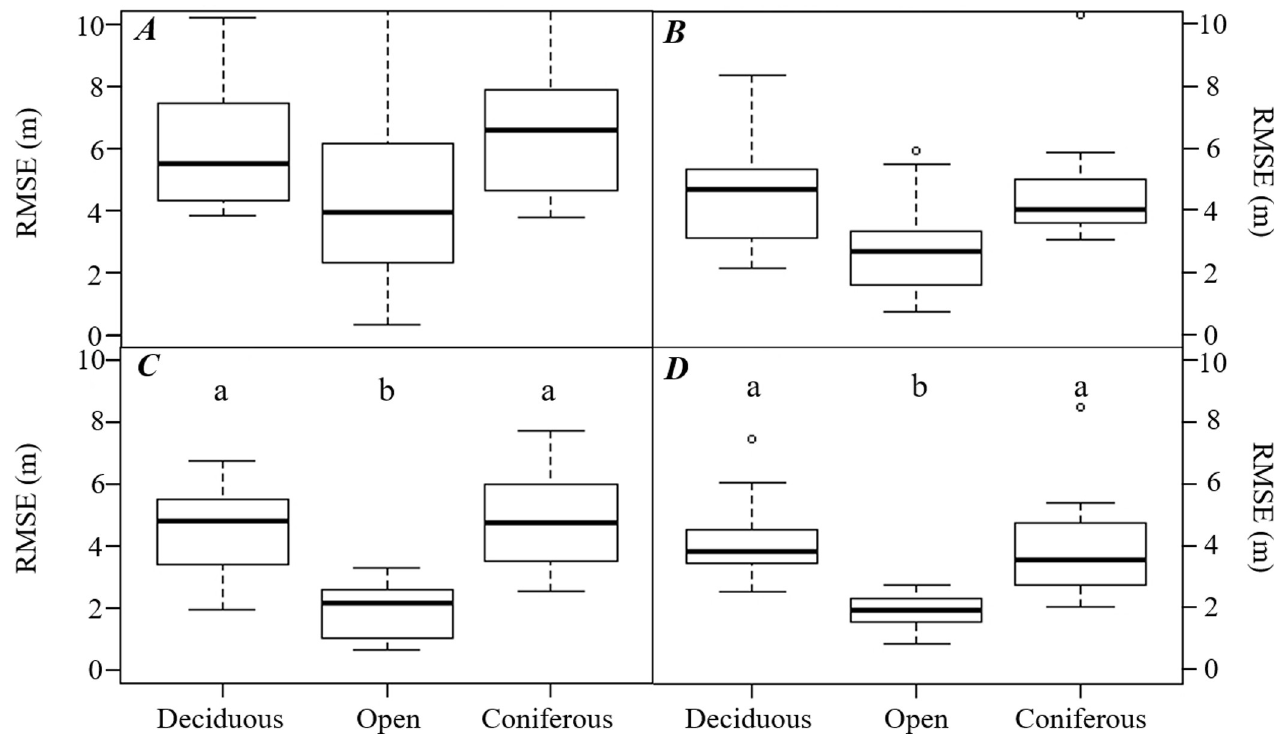
Fig 2. Boxplots for horizontal positional accuracy (RMSE) by equipment type (GPS watch: A , B ; Mapping-grade GNSS receiver: C , D ), cover type, and season (Leaf-on: A , C ; Leaf-off: B , D ). Different letters indicate significant differences (For A and B , Scheffe’s Test at p-value < 0.05; for C and D , Dunn’s Test at p - value <